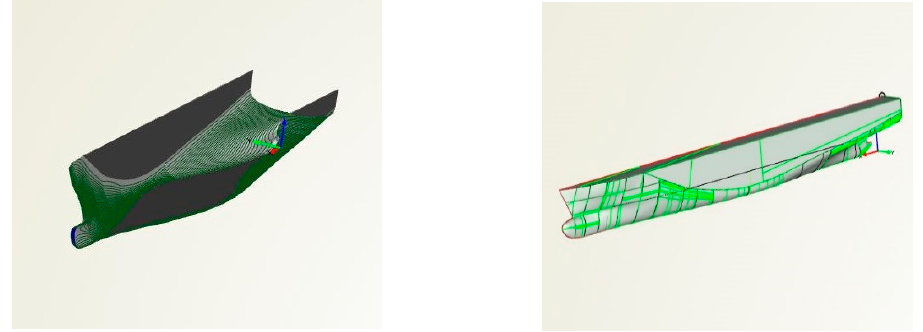
Figure 2. The geometry of KRISO containership as derived by CAESES software.